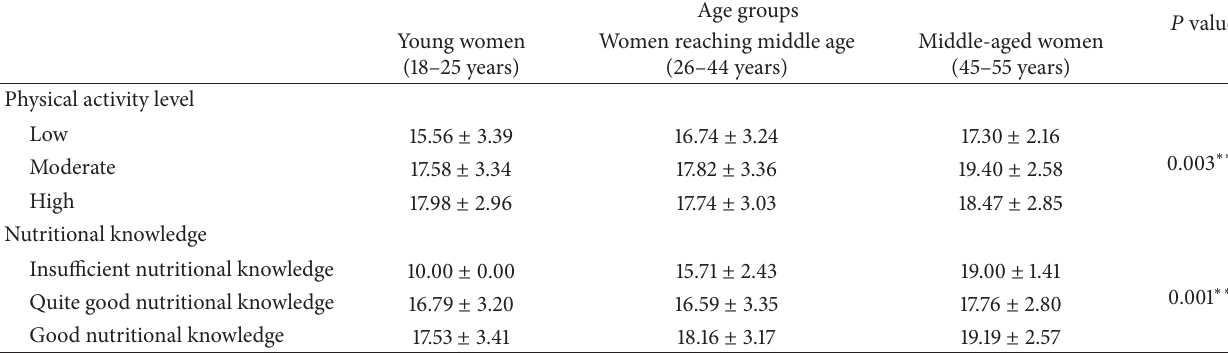
Table 3: Effect of age on the association between dietary quality (mean score ± SD) and PAL as well as nutritional knowledge.